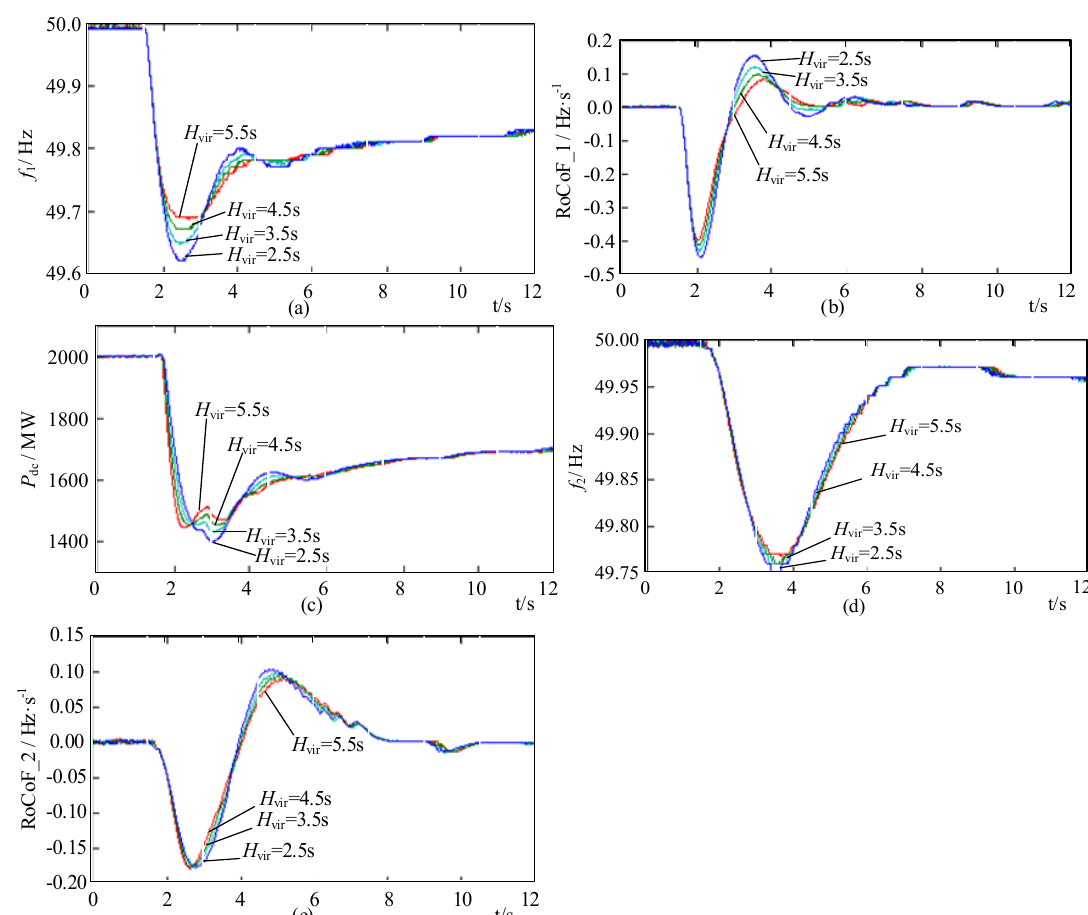
Figure 14. Response characteristics with different inertia constant. ( a ) The frequencies of the sending-end system; ( b ) the RoCoF of the sending-end system; ( c ) the actual power transmitted by the UHVDC; ( d ) the frequencies of the receiving-end system; ( e ) the RoCoF of the receiving-end system.